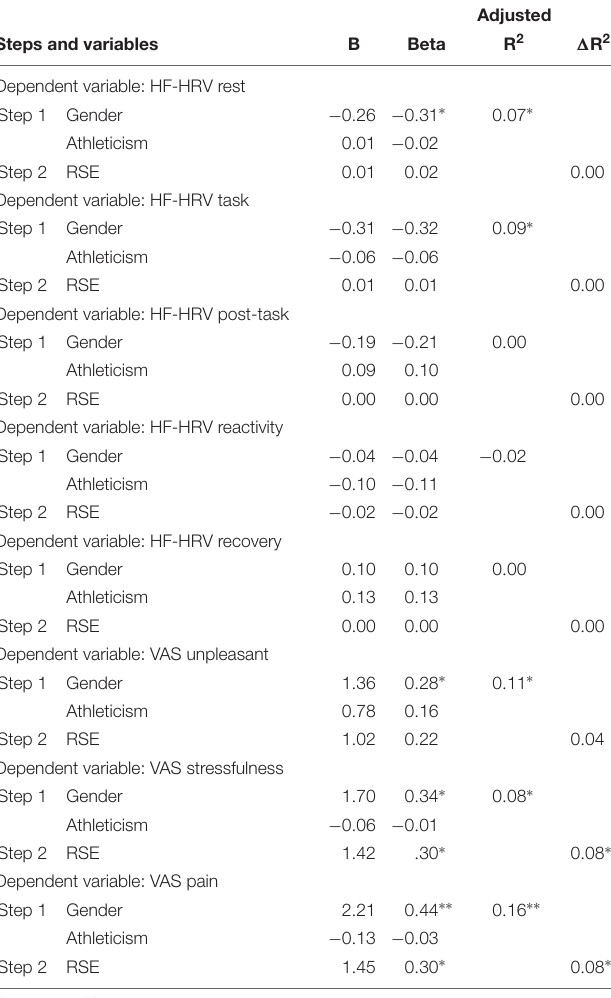
TABLE 6 | Multiple regression analyses for RSE whilst controlling for gender and athleticism at step 1.